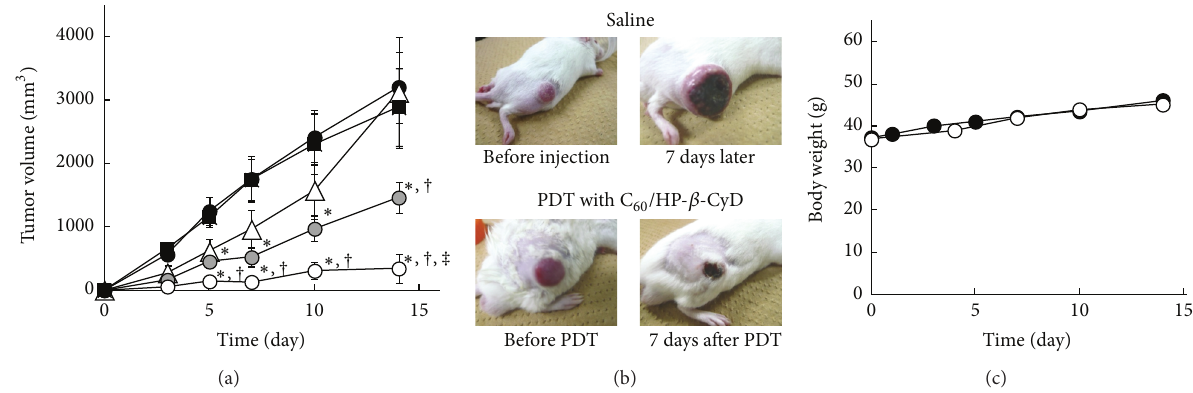
Figure 6: Photodynamic effects of C 60 /HP- 𝛽 -CyD nanoparticles on tumor growth (a). Appearances of tumor (b) and changes in body weight (c) after intratumor injection to the tumor-bearing mice plus light irradiation. Black filled circle: saline; black filled square: C 60 /HP- 𝛽 -CyD; empty triangle: saline plus light irradiation (63 J/cm 2 ); shadowed circle: C 60 /HP- 𝛽 -CyD (0.4 mg/kg) plus light irradiation (63J/cm 2 ); empty circle: C 60 /HP- 𝛽 -CyD (2.0mg/kg) plus light irradiation (63 J/cm 2 ). Each point represents the mean ± S.E. of 6–9 experiments. ∗ 𝑃 < 0.05 versus saline. † 𝑃 < 0.05 versus saline plus light irradiation. ‡ 𝑃 < 0.05 versus C 60 /HP- 𝛽 -CyD (0.4 mg/kg) plus light irradiation (63 J/cm 2